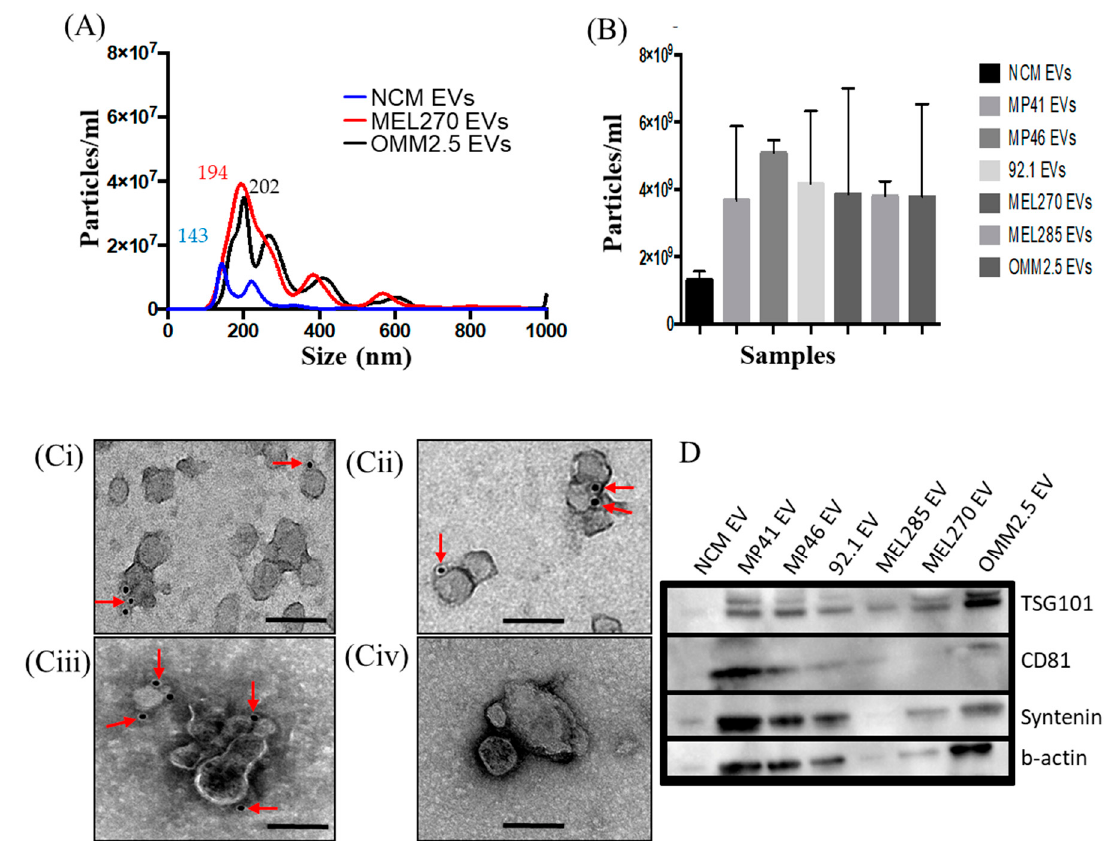
Figure 1. Characterization of extracellular vesicles (EVs) derived from normal choroidal melanocytes (NCMs) and Uveal Melanoma (UM) cells. ( A , B ) Nanoparticle tracing analysis NTA of EVs derived MEL270, metastatic UM cells (OMM2.5) and NCMs. ( B ) NTA data showing concentrations of EVs from di ff erent cell sources. Data are expressed as mean ± SD ( n = 3). ( C ) Representative micrographs of immunoGold-TEM on MP46-EVs ( Ci – Cii ) 92.1-EVs ( Ciii ) and NCM-EVs ( Civ ) labelled with a cocktail of antibodies against CD81 ( Ci ), TSG101 ( Cii ) and CD63 ( Ciii ) (red arrows). Scale bars 200 nm. ( D ) Proteins i solated from EVs derived from di ff erent cell sources were analyzed by Western blot for the expression of specific exosome